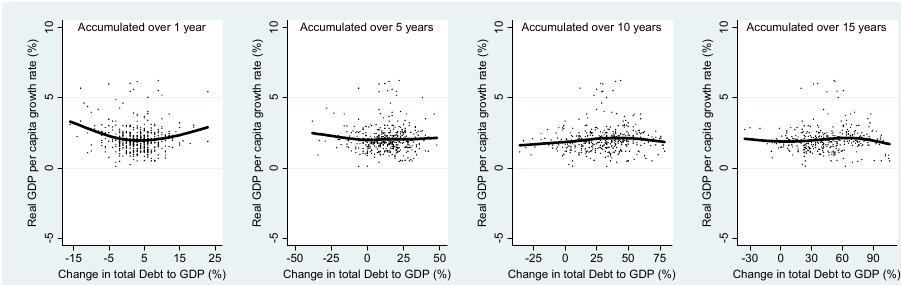
Figure 14 - Growth performance over 15 year with debt accumulation over 1-15 year (h=15 and